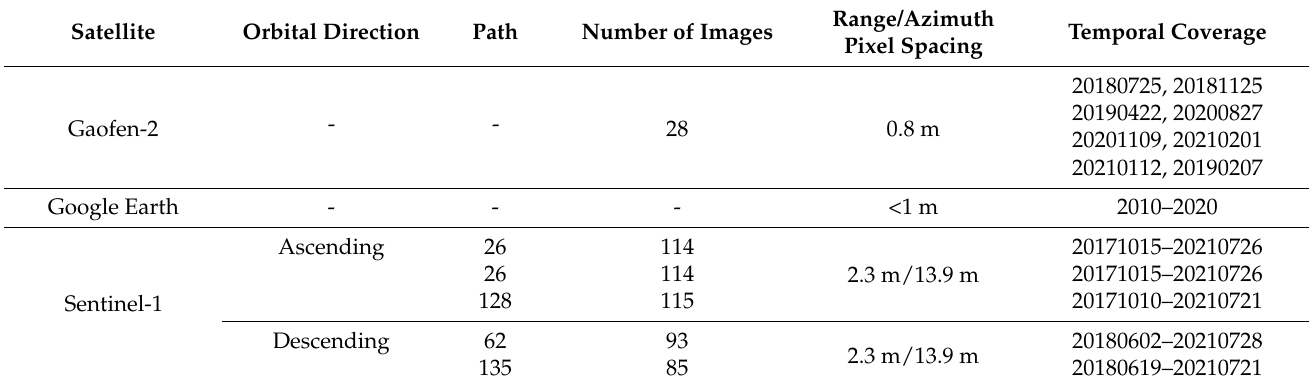
Table 1. SAR and optical images used in this